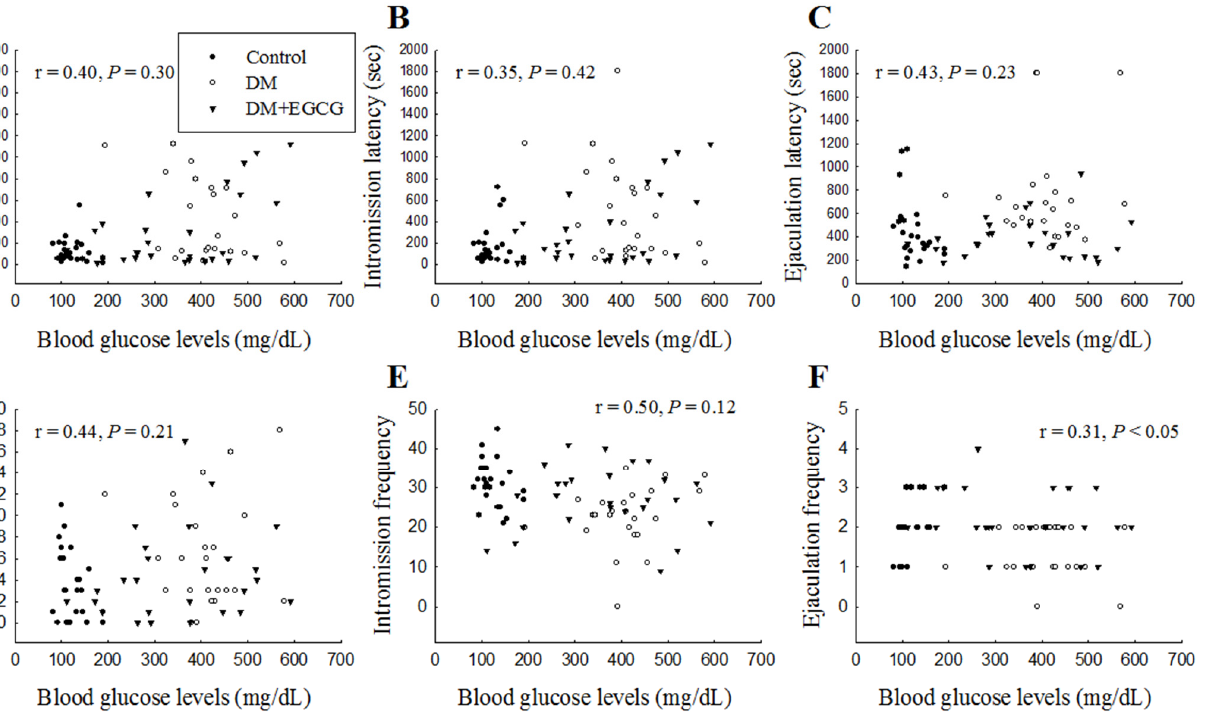
Figure 4. Linear correlation between sexual behavioral parameters ( A ) mount latency, ( B ) intromission latency, ( C ) ejaculation latency, ( D ) mount frequency, ( E ) intromission frequency, and ( F ) ejaculation frequency with blood glucose levels in each group over 14 days of EGCG or distilled water treatment. DM, diabetes mellitus; EGCG , epigallocatechin